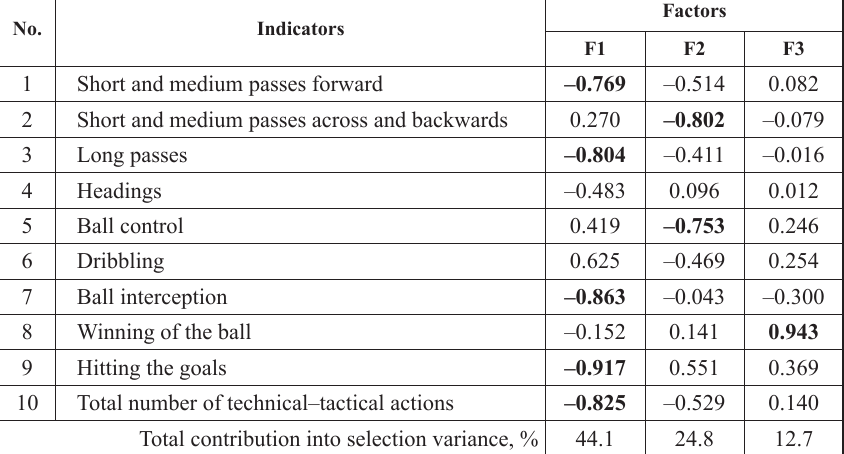
Table 2. Factor structure of technical-tactical actions